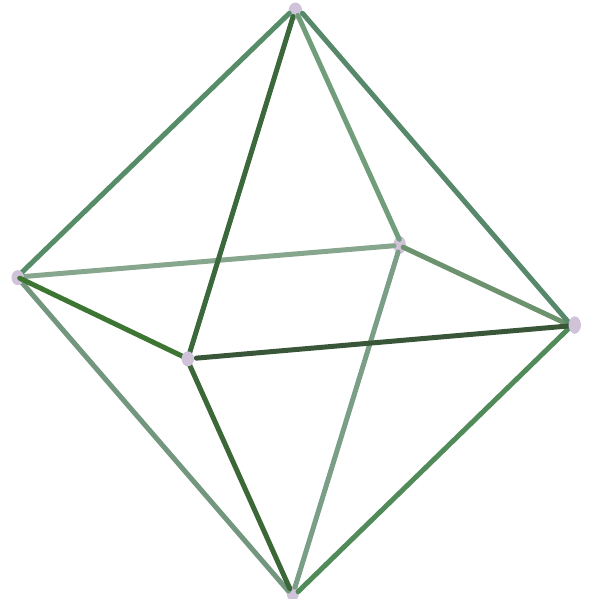
Figure 3: The regular